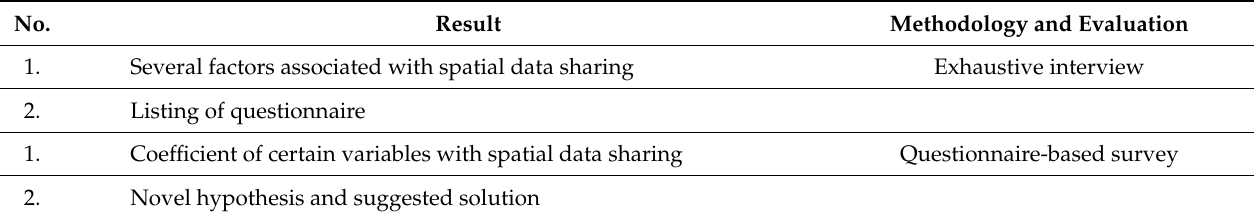
Table 4. Data collecting and analysis techniques.